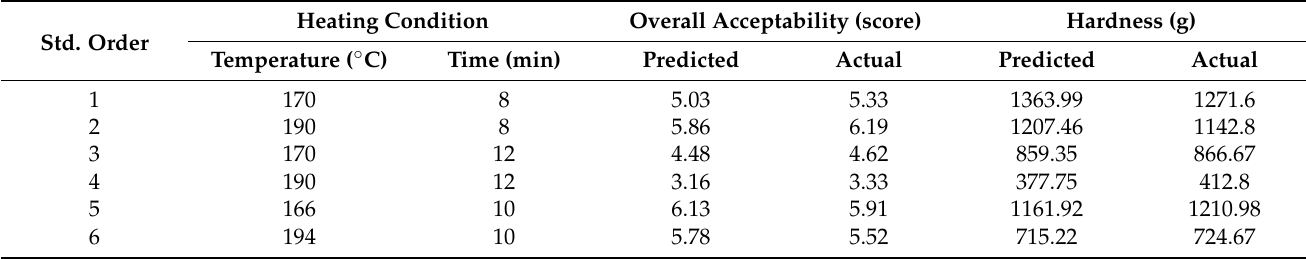
Table 4. Predicted and actual values of overall acceptability and hardness of braised mackerel in central composite design. Std.